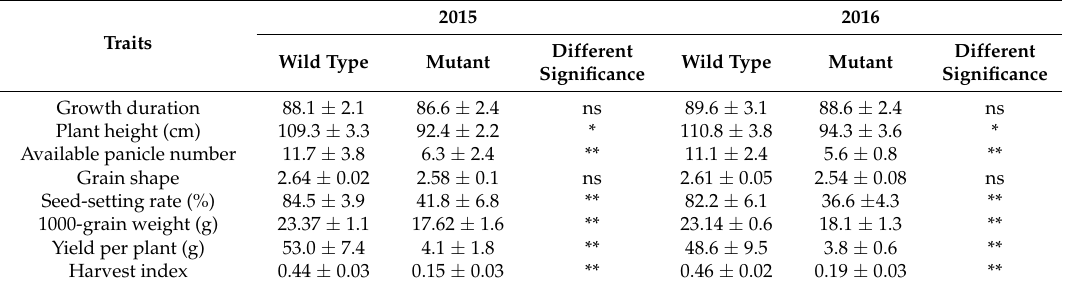
Table 1. Variation of important agronomic traits between ospls1 mutant and wild type. Traits